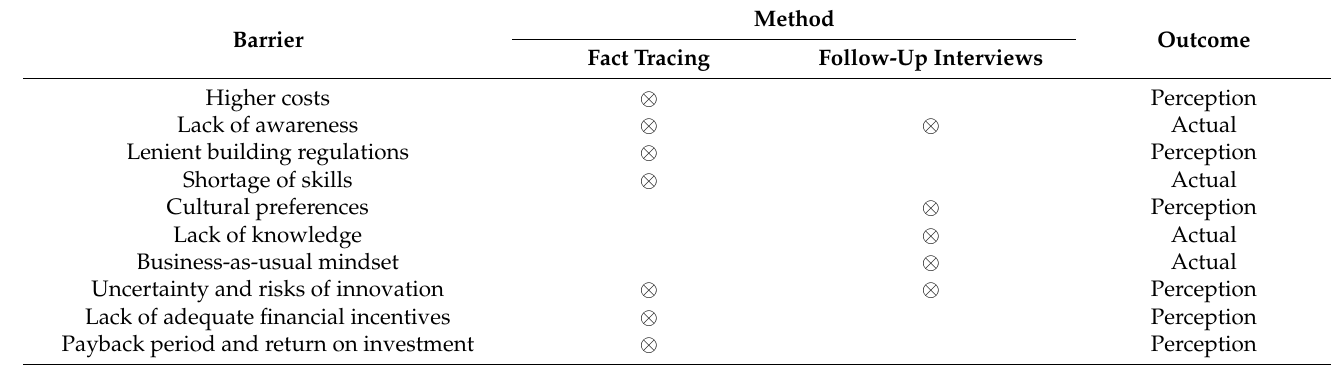
Table 9. Summary table of